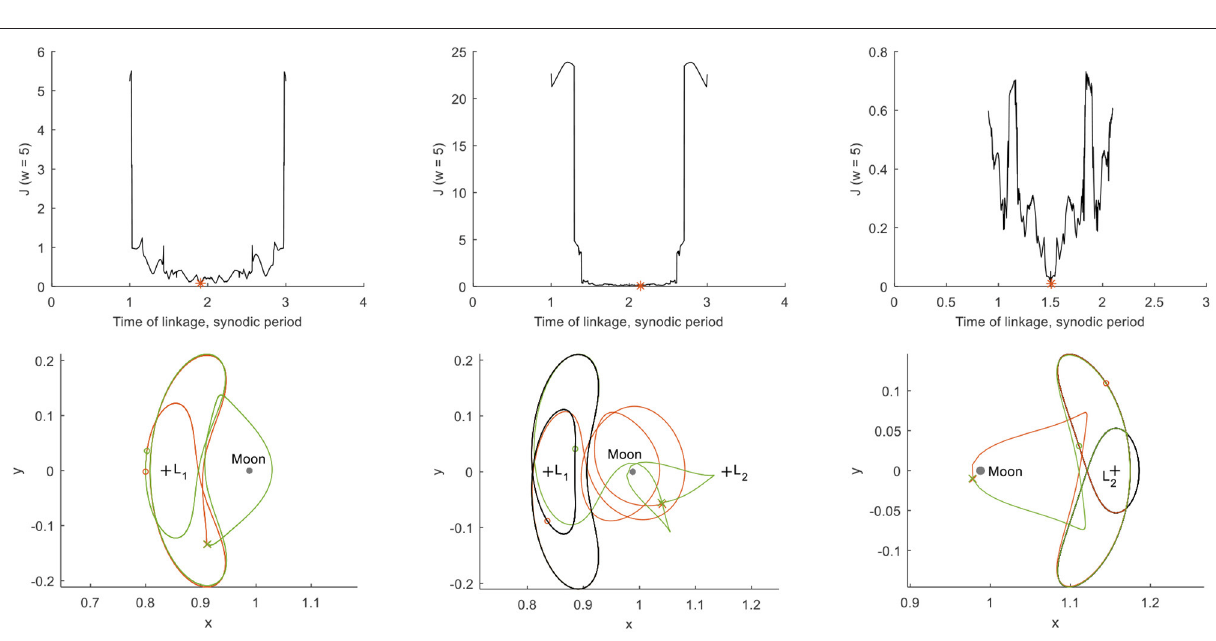
FIGURE 9 | Search for homoclinic connections for a free linkage time (FLTR: transfers